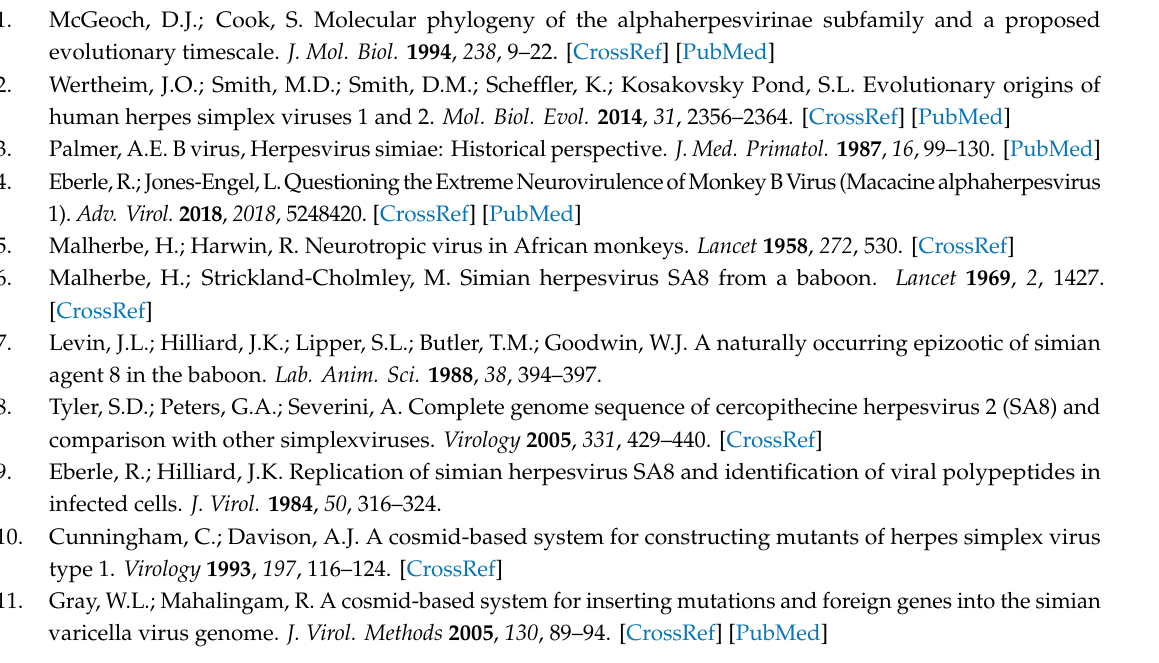
Figure S1: Rescue of recombinant CeHV-2